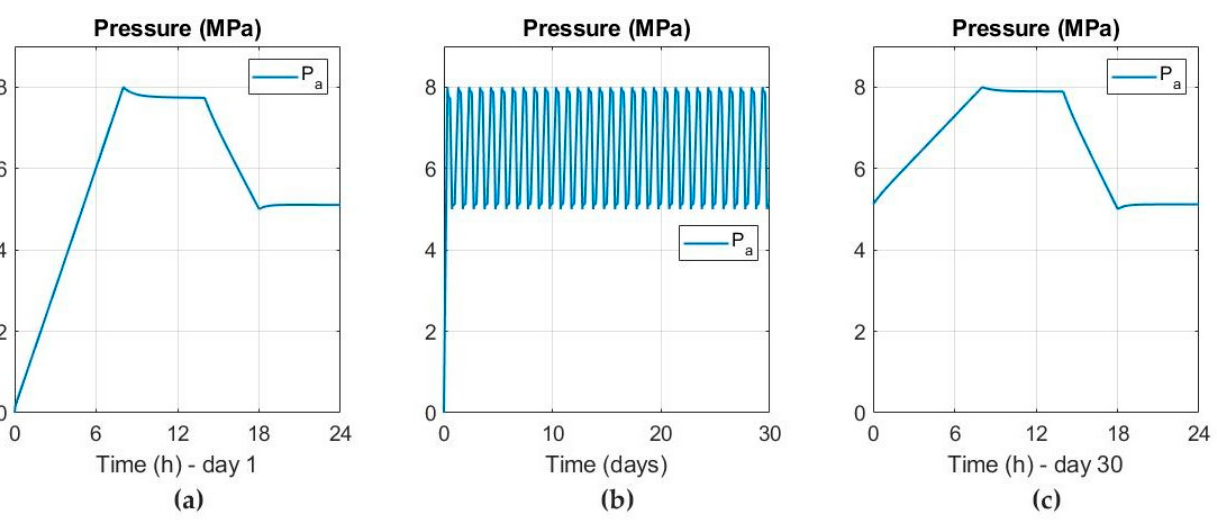
Figure 5. Air pressure for 30 charging and discharging cycles considering FRP as sealing layer. ( a ) First cycle; ( b ) 30 days of operation; ( c ) 30th cycle.